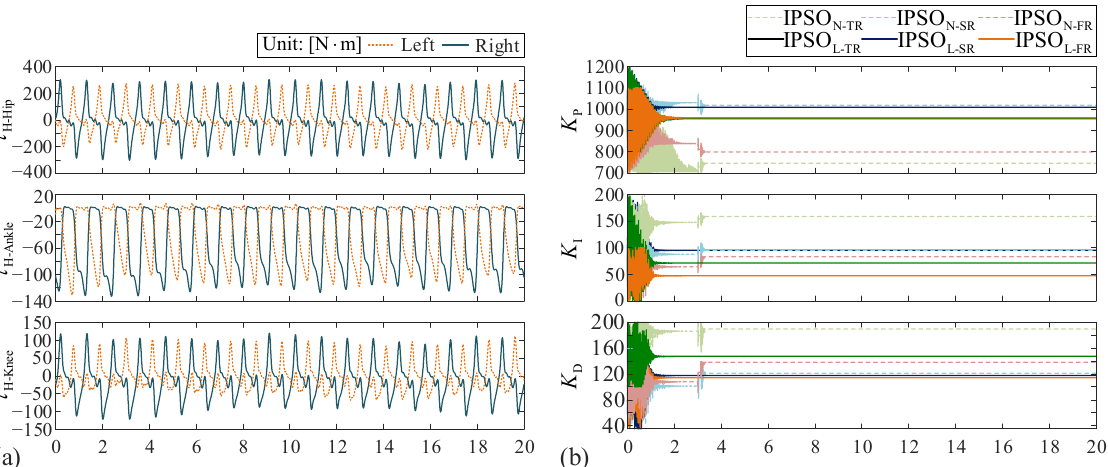
Figure 8. Comparison between the normal mode and the low power mode. ( a ) Human effects applied to the exoskeleton in the low power mode. ( b ) Evolution of the PID gains corresponding to the normal mode (denoted by subscripts ‘N’) and the low power mode (denoted by subscripts ‘L’), they converge to significantly different values.